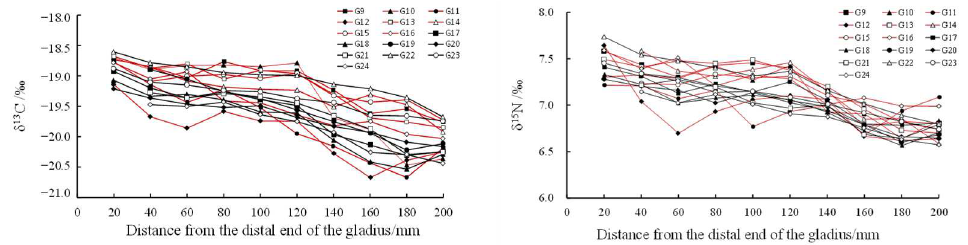
Figure 7. Relationship between δ 13 C‰, δ 15 N‰, and the growth of the proostracum of T. pacificus collected in the Sea of Japan. (Black line represents males, and red line represents females.)